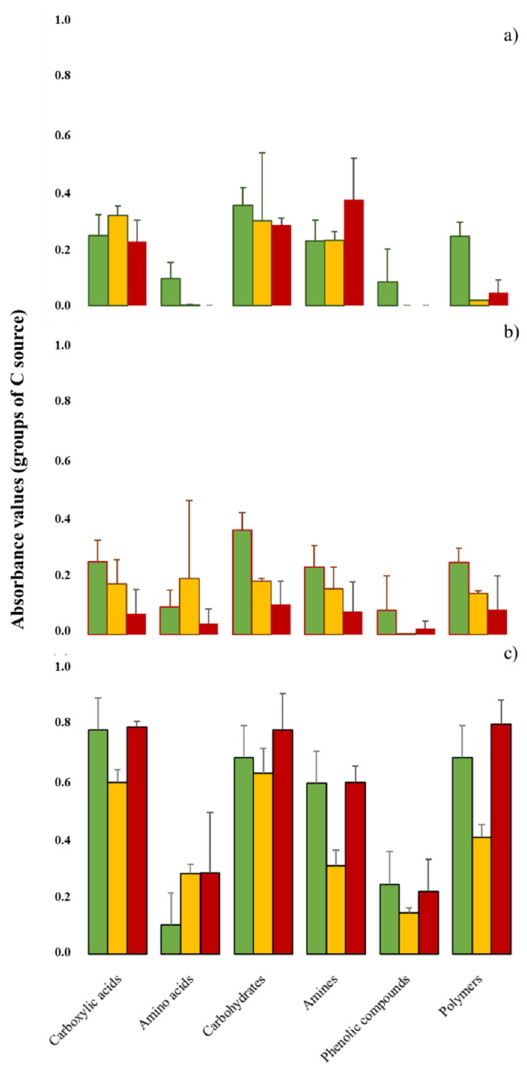
Figure 3. The six C source groups (carboxylic acids, amino acids, carbohydrates, amines, polymers, and phenolic compounds) were characterized after 96 h of incubation (midexponential growth phase) in soils of burned lysimeters at MedForECOtron (14 July 2016) collected: ( a ) prefire (7 days before, PRE); ( b ) one day after (1Dafter); ( c ) 6 months after (180Dafter). Burn severity levels: unburned (UB, green), low burn severity (LOWsev, orange), and high burn severity (HIGHsev, red). Spearman’s linear correlation analysis (Figure 4) showed that after 96 h of incubation, the average use of the CLPP substrates and the six C source groups were positively and significantly correlated and with other physico-chemical parameters. The highest correla- tion related AWCD to CA (+0.97), AAC (+0.94), CH (+0.91), and POL (+0.95). H’ strongly